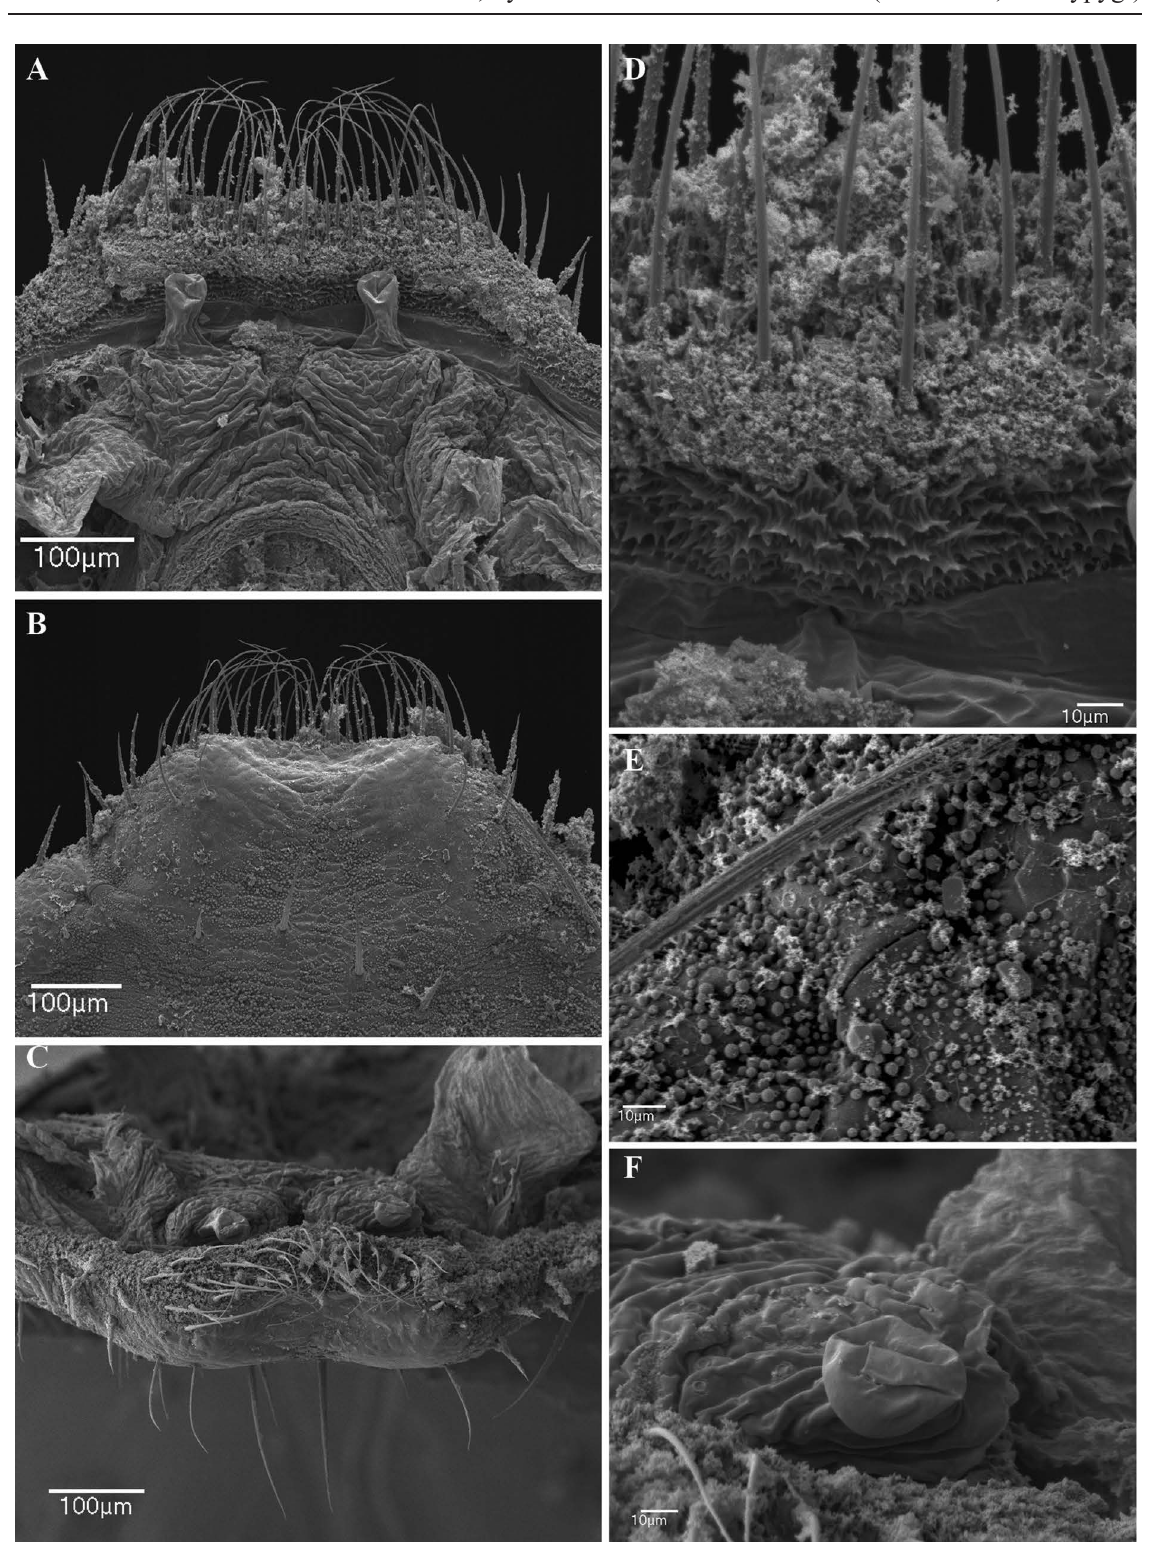
Fig. 113. Sarax indochinensis sp. nov. (ZMUC 21612), female gonopod and genital operculum. A . Finger- like gonopod, dorsal view. B . Posterior margin of genital operculum, ventral view. C . Gonopods, posterior view. D . Genital operculum between gonopods. E . Glandular opening on margin of genital operculum. F .